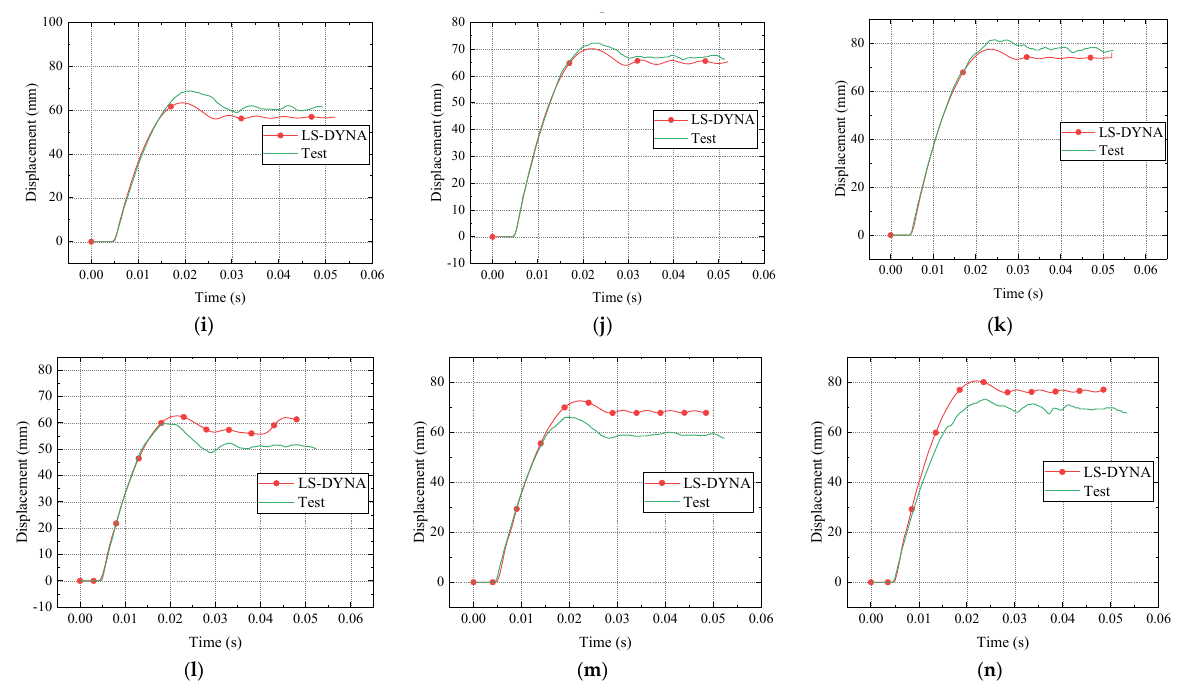
Figure 6. Mid-span deflection–time history curve. ( a ) RC; ( b ) RC0.3; ( c ) H-DS; ( d ) H-DS0.3; ( e ) H- DS0.5; ( f ) S-ST; ( g ) S-ST0.3; ( h ) S-ST0.5; ( i ) R-ST; ( j ) R-ST0.3; ( k ) R-ST0.5; ( l ) S-DS; ( m ) S-DS0.3; ( n ) S-DS0.5.